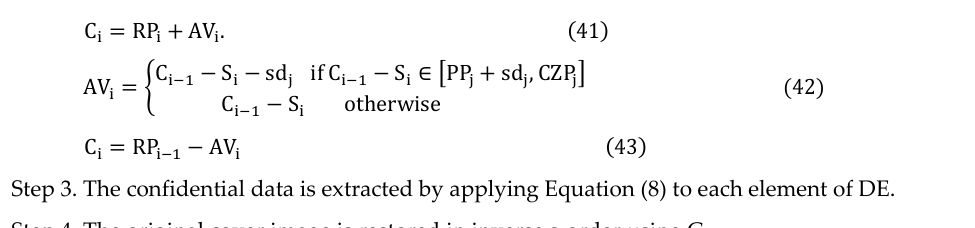
Figure 10. Confidential data extraction procedure and the original cover image restoration procedure of ARDHA .